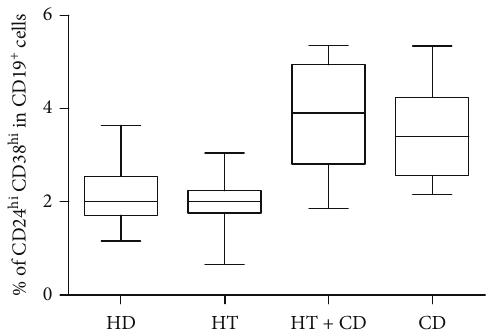
Figure 2: Nonstimulated Breg cells. Percentage of Breg cells (CD24 hi CD38 hi ) in healthy donors (HD), in patients with isolated Hashimoto thyroiditis (HT), in patients with Hashimoto thyroiditis plus celiac disease (HT+CD), and in patients with celiac disease (CD). Box plots indicate median, interquartile range (box), and minimum and maximum values (whiskers). Nonparametric Kruskal-Wallis test p = 0 0010 . Dunn